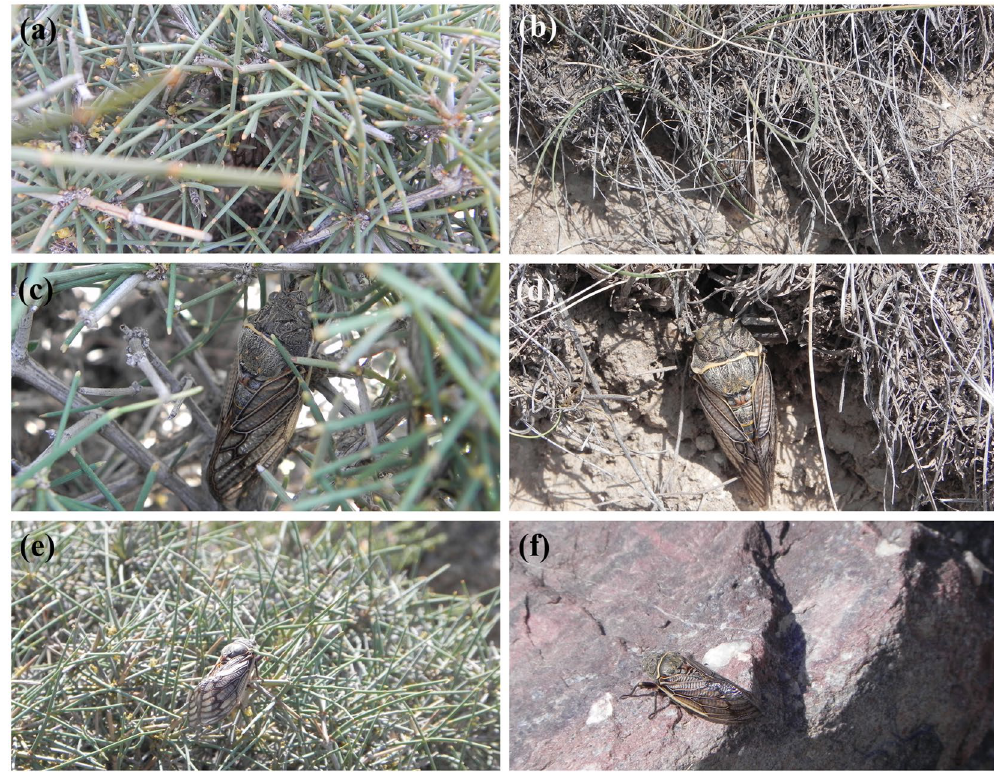
Figure 1. Females and males choose different places to produce sounds. ( a – d ) Females. ( e – f ) Males. ( a ) A female producing sounds in the canopy of the host plant. ( b ) A female producing sounds among grasses. ( c ) Some stems of the plant were removed to show the signaling female in ( a ), which has the body (including forewings) colours matching to clumps of branches and leaves of the host plant. ( d ) Some leaves of the grasses were removed to show the signaling female in ( b ), which has the body (including wings) colours matching to clumps of the withered vegetation. ( e ) A male calling from exposed perch site (the top of the host plant). ( f ) A male calling on the top of a